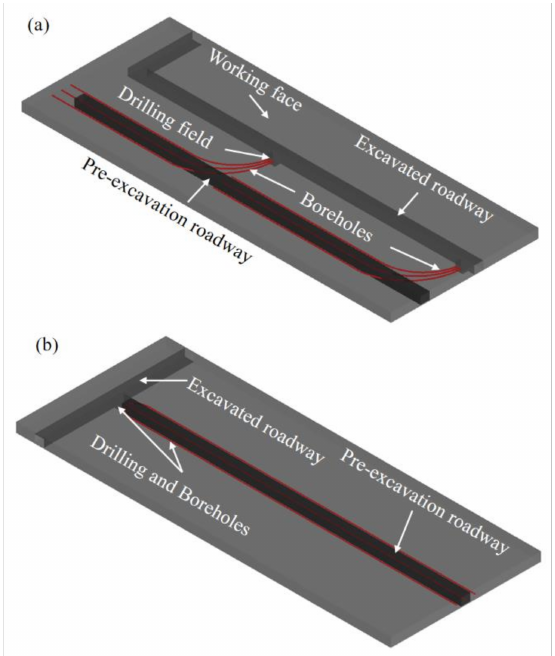
Figure 2. Schematic diagram of gas pre-drainage in the heading face with directional long borehole. ( a ) Construction borehole at the gateway. ( b ) Construction borehole at preparation